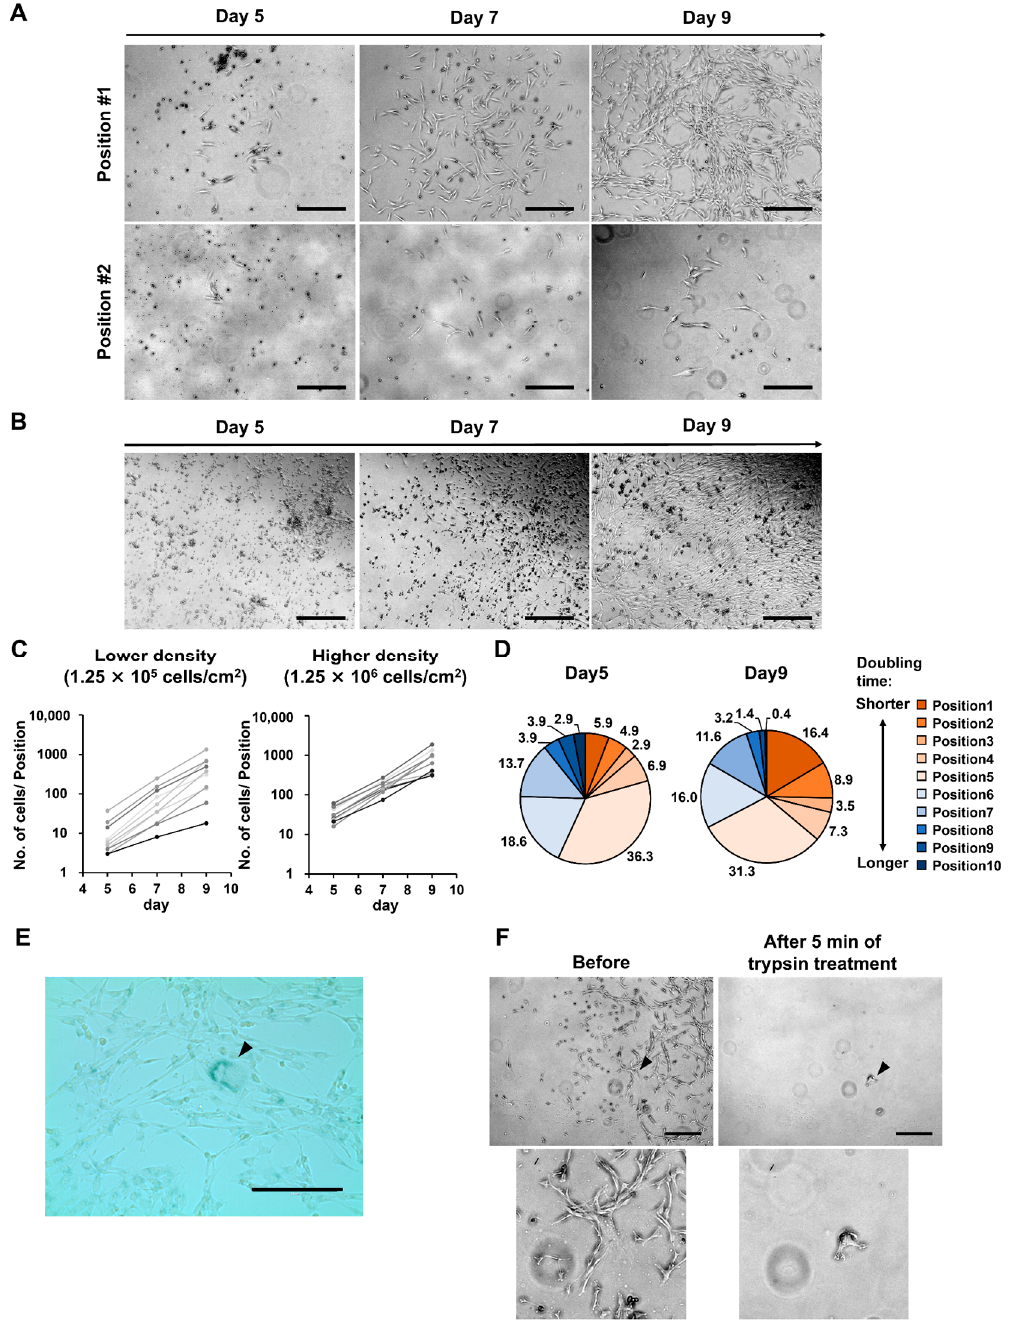
Figure 2. At lower mononuclear cell (MNC) seeding density, the ratio of fast-growing cells become predominant, depending on the superiority of their proliferative ability. ( A , B ) Each colony was ob- served over time using a phase-contrast microscope. The scale bar indicates 500 µm. Examples are shown for ( A ) a lower seeding density (1.25 × 10 5 cells/cm 2 ) and ( B ) a higher seeding density (1.25 × 10 6 cells/cm 2 ). ( C ) The number of cells per position of colonies formed at each seeding density is shown. ( D ) Ratio of cells in each position relative to the total cell count at a lower seeding density (1.25 × 10 5 cells/cm 2 ). Each position was color-coded based on doubling time. Numbers in the graph indicate %. ( E ) Enlarged cells seen at lower seeding density were stained with senescence-associated β -galactosidase (SA β -Gal) stain. Arrowheads point to enlarged senescent cells. The scale bar indi- cates 200 µm. ( F ) At lower seeding density, trypsin detachment treatment (5 min) was performed. The same position was observed microscopically before and after treatment. Arrowheads point to cells remaining after detachment treatment. The scale bar indicates 200 µm.